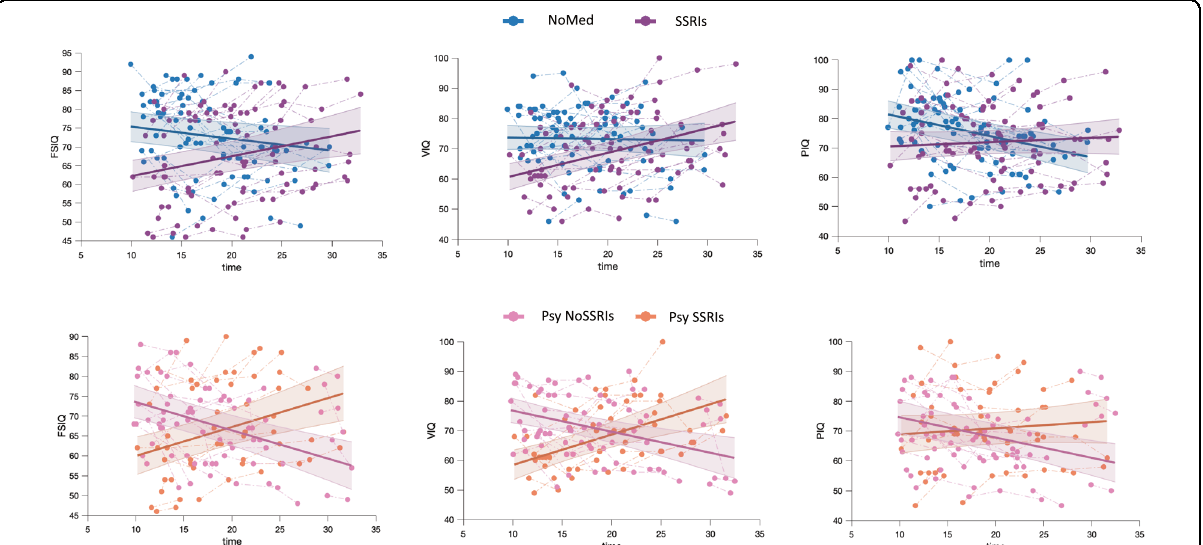
Fig. 1 IQ trajectories. Developmental trajectories of full-scale IQ (FSIQ), performance IQ (PIQ) and verbal IQ (VIQ) scores in deletion carriers with and without treatment with SSRIs (upper panel) and deletion carriers endorsing psychotic symptoms with and without treatment with SSRIs (lower